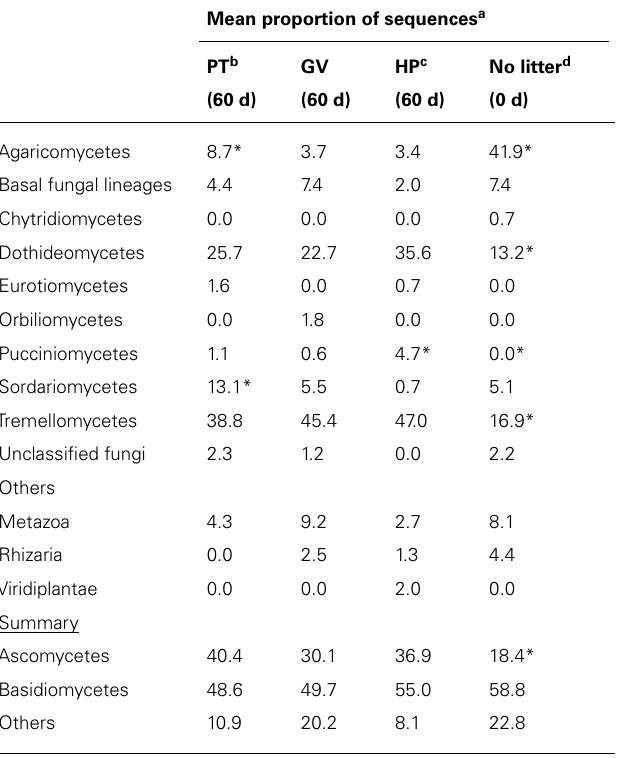
Table 7 |Taxonomic classification of 18S sequences in microcosms with soil and leaf litter from Populus tremuloides .